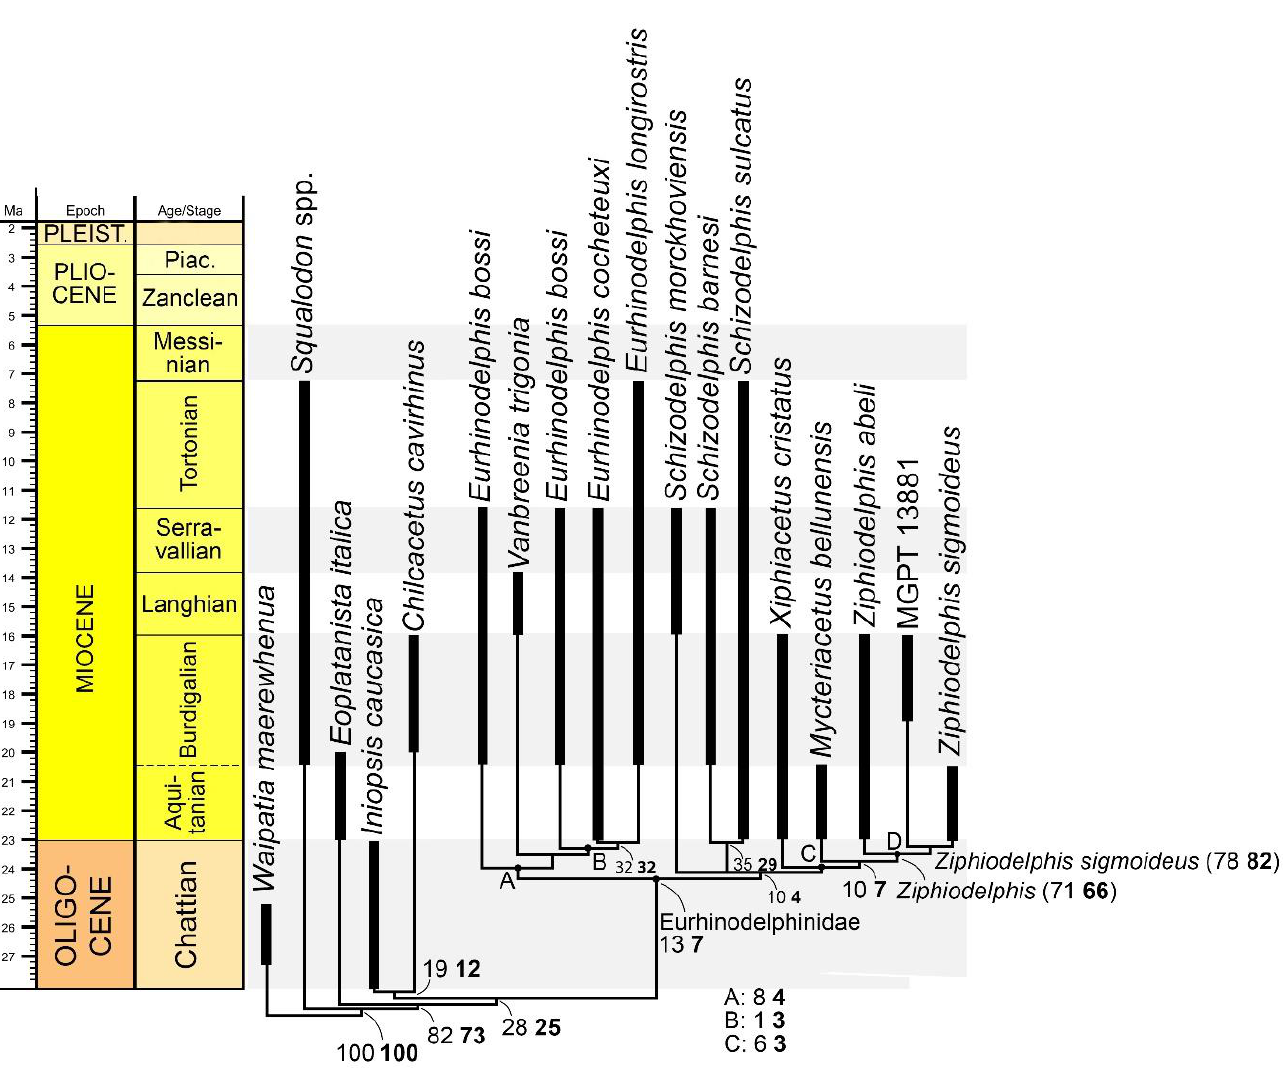
Figure 19. Phylogenetic relationships of Eurhinodelphinidae plotted against a temporal scale. Bold numbers represent bootstrap support values; regular numbers represent symmetric resampling supporting values.